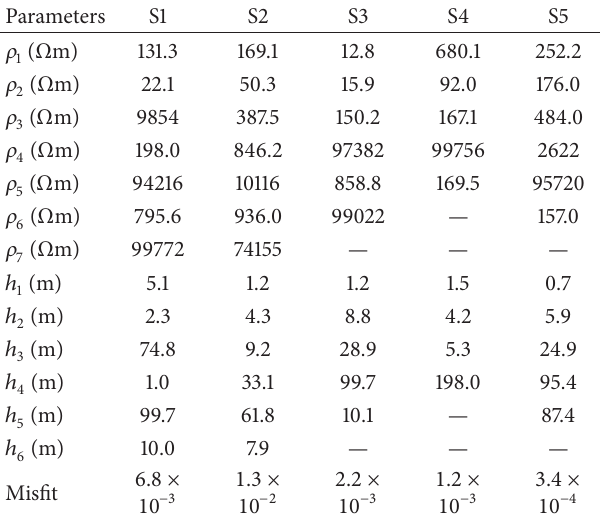
Table 1: Interpreted model parameters for five